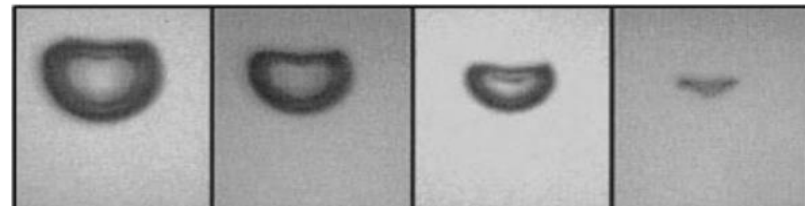
Figure 5. Experimental images: λ = 2.5, 𝑅 0 = 1.45 × 10 −3 m .